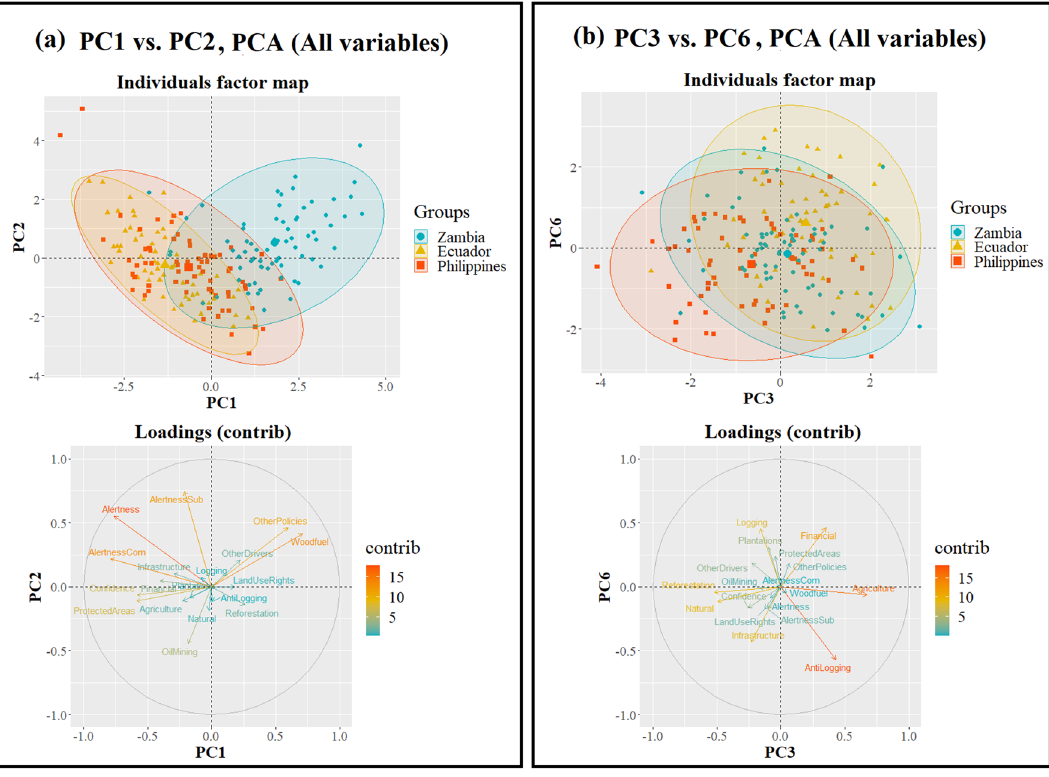
Figure 5. Results of the PCA with all the eighteen studied variables: biplots of the individuals grouped by country (ellipse of 95% confidence) and loadings of the variables for the two first components ( a ) and for the third and sixth component ( b